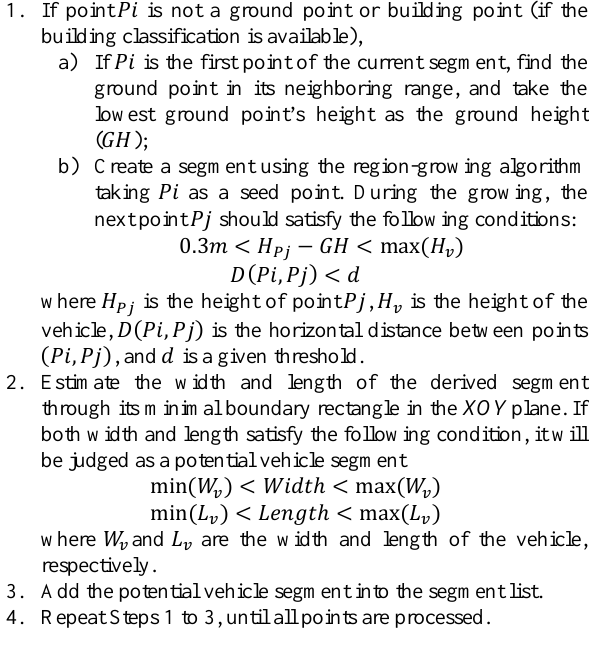
Algorithm 1 : Potential vehicle segment extraction